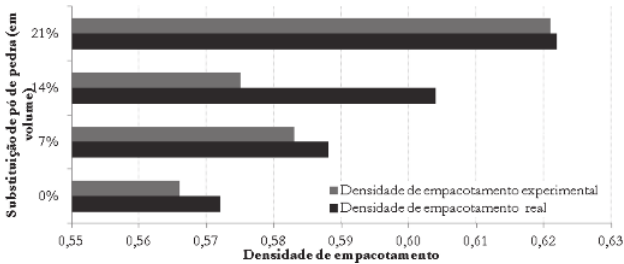
Figura 11 Densidade de empacotamento experimental e analítica de cada teor de substituição do cimento pelo pó de